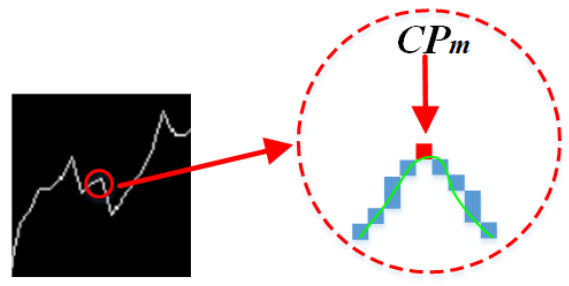
Figure 5. Sub points set centered at 𝐶𝑃 (cid:3040) .